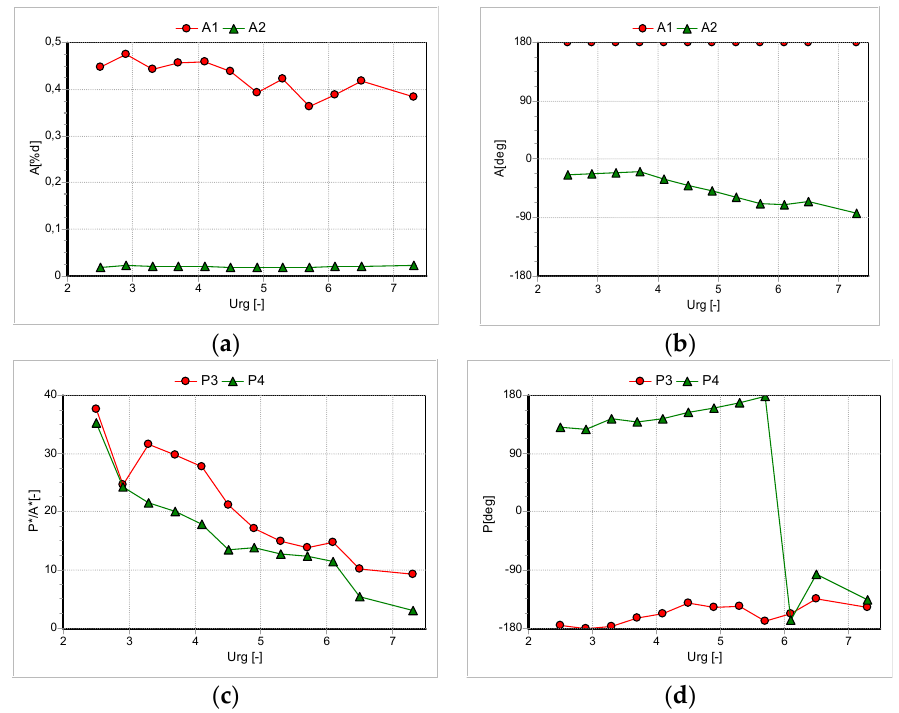
Figure 5. Amplitude and phase measurements observed in accelerometers and pressure transducers respectively: ( a ) Amplitude of vibration in Y = A1 and X = A2 coordinates; ( b ) Phases for tube motion in Y = A1 and X = A2 coordinates; ( c ) Amplitude of pressure perturbations in P4 = T2 and P3 = T3 locations in the array (see Figure 1); ( d ) Phase of pressure perturbations in P4 = T2 and P3 = T3 locations in the array (see Figure